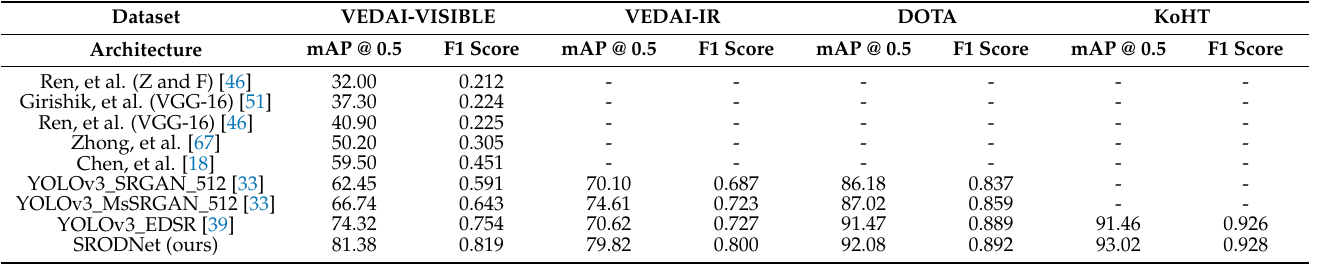
Table 4. Comparative detection performance in terms of mean average precision (mAP) and F1-score of the proposed model and existing state-of-the-art